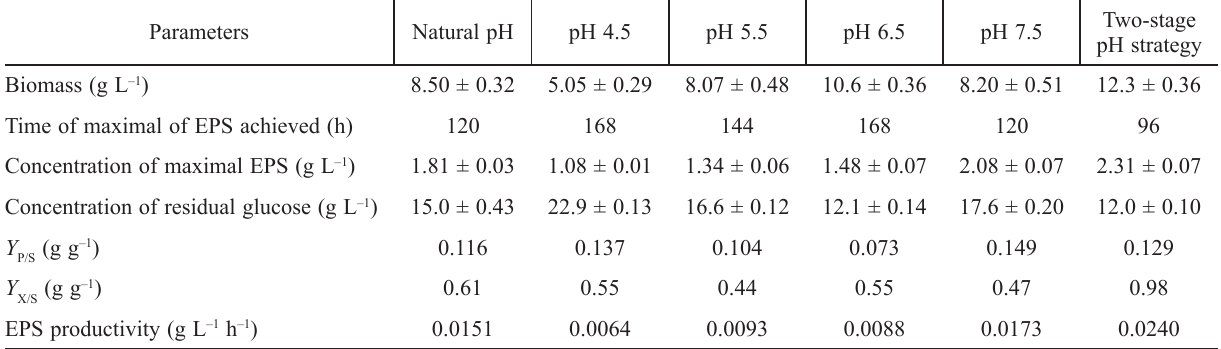
Table 2 – Kinetic parameters of different pH strategy by H. marmoreus in a 5-L bioreactor